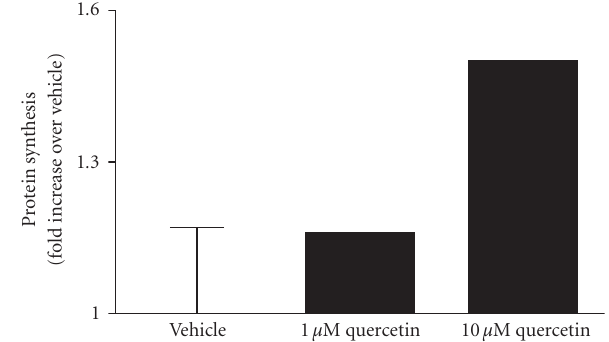
Figure 6: E ff ect of HRI inhibition on protein synthesis by quercetin in canine blood cells. Total protein synthesis in canine blood was determined by [ 35 S]-methionine incorporation into newly synthesized protein in the presence of 1 or 10 μ M quercetin. The amounts of [ 35 S]-methionine incorporation were compared to a vehicle control of 1% DMSO and the fold increase with the mean ± SEM from replicates is